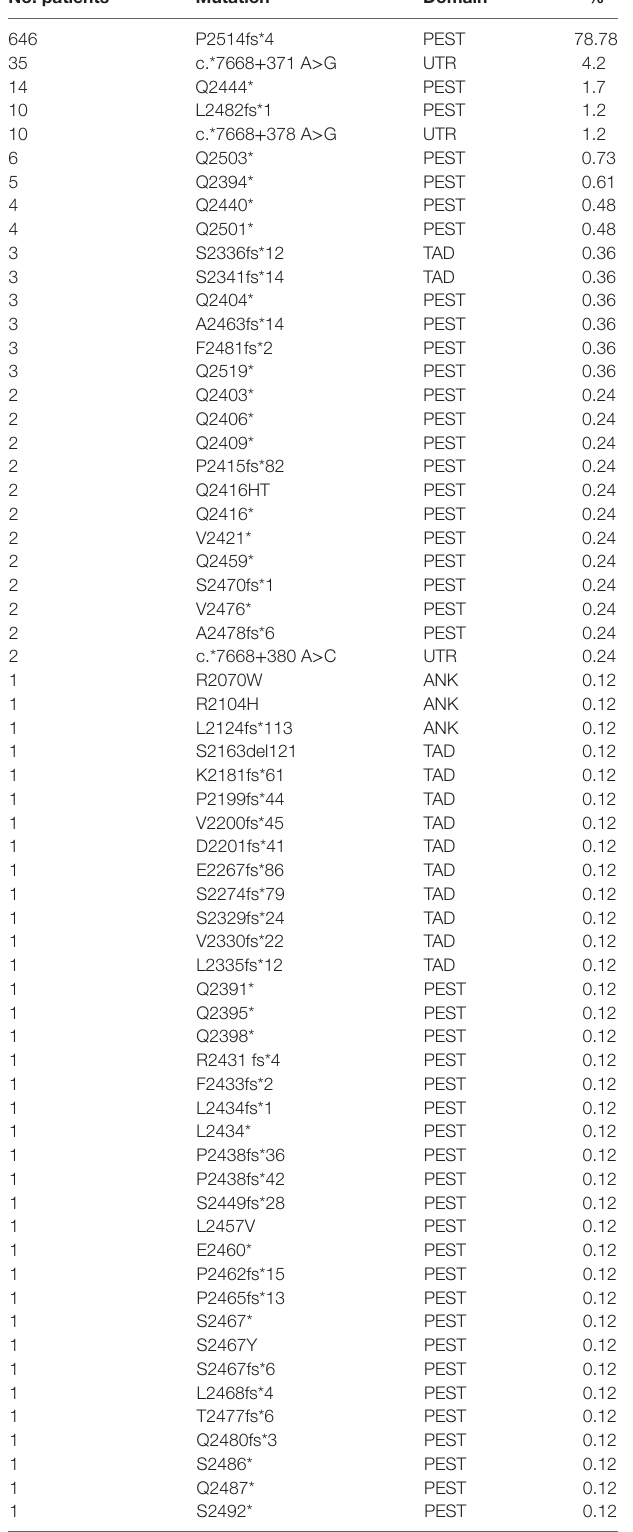
TABLe 1 | Frequency of genetic variants of NOTCH1 mutations across different chronic lymphocytic leukemia studies. No.